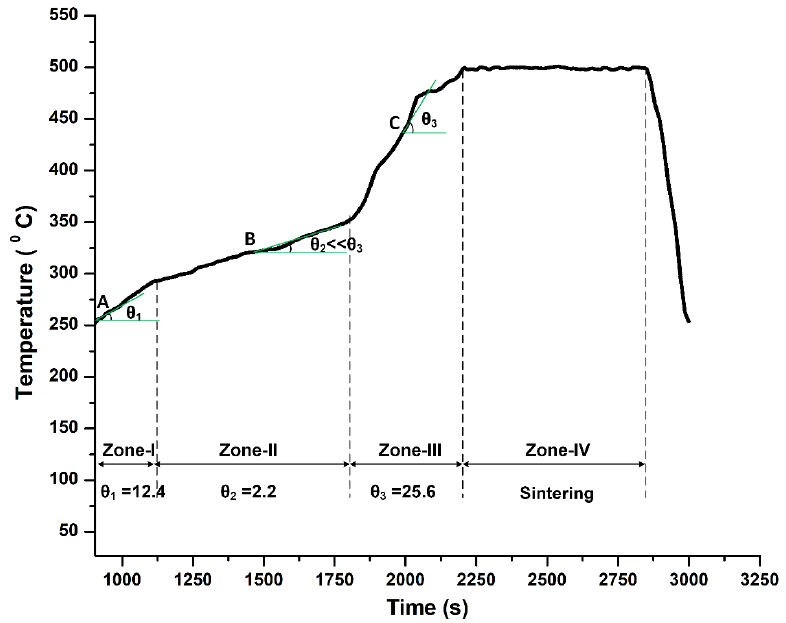
Figure 2. Time – temperature curve in microwave sintering of AZ31-15HA BMMC. Figure 2. Time–temperature curve in microwave sintering of AZ31-15HA BMMC.